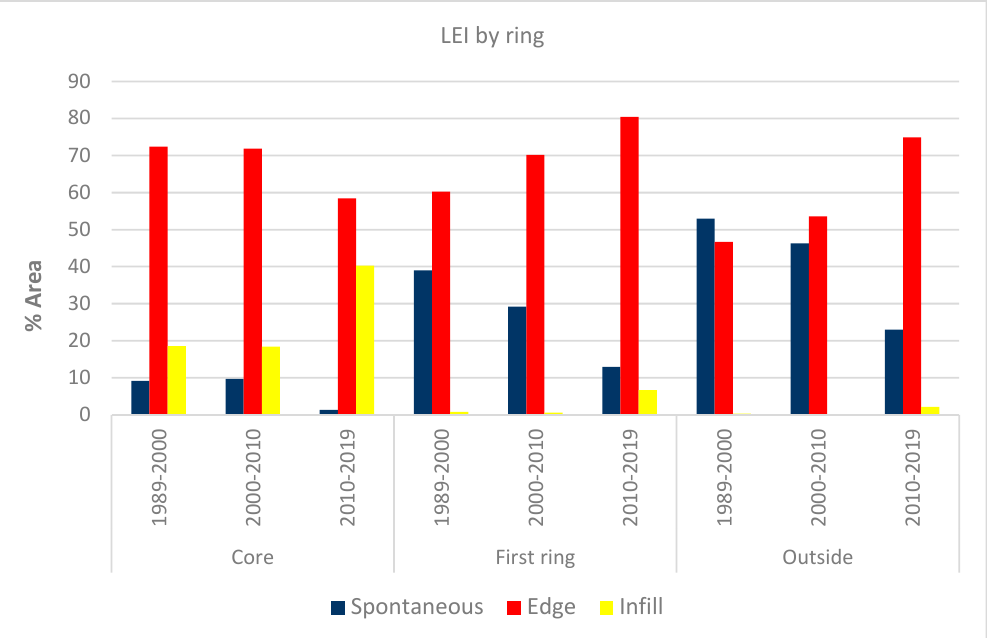
Figure 13. Percent values of area by ring and by type of building expansion (spontaneous, edge expansion or infill) in the three different periods (1989–2000, 2000–2010 and 2010–2019).